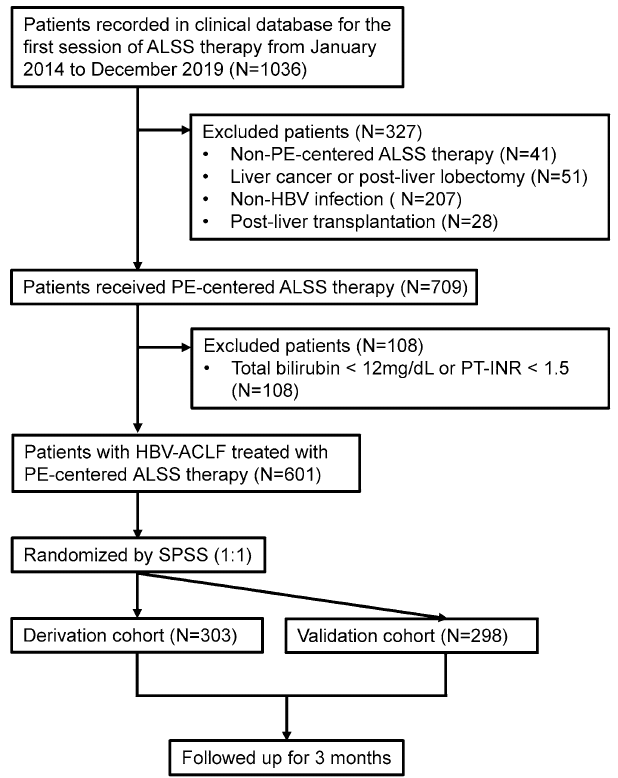
Figure 1. Flow diagram of patient selection. Of the 1036 patients in our database that received ALSS therapy, 435 were excluded from the study. The remaining 601 patients with HBV-ACLF were randomly divided into a derivation cohort (N = 303) and a validation cohort (N = 298). ALSS artificial liver support system, PE plasma exchange, HBV hepatitis B virus, ACLF acute-on-chronic liver failure, SPSS SPSS v.22 (IBM